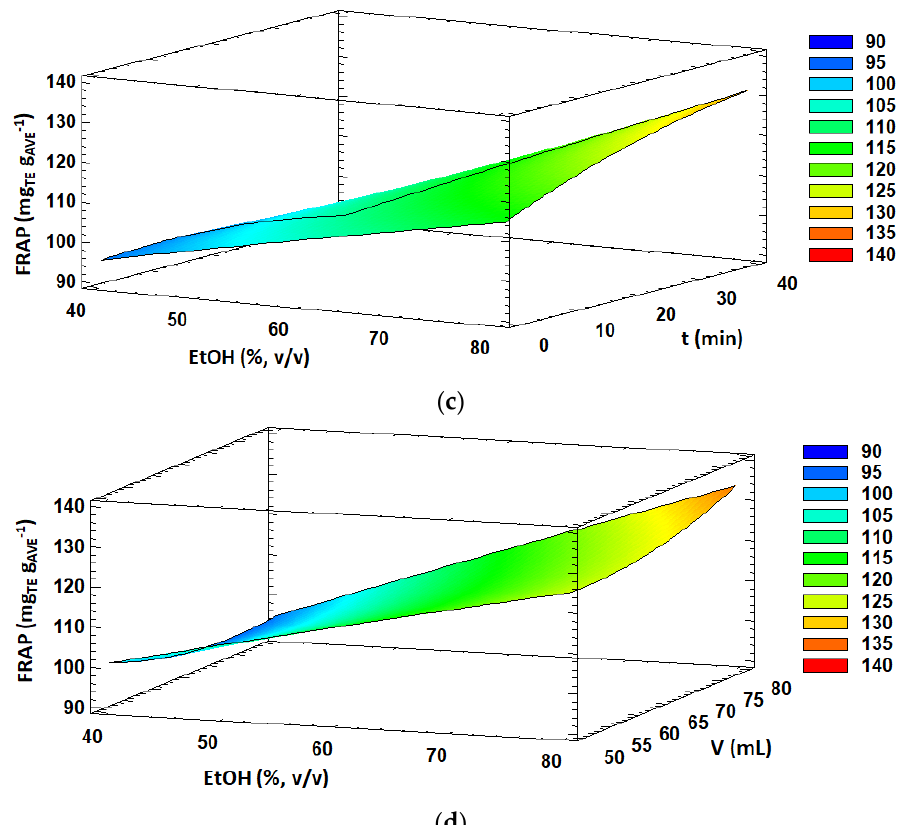
Figure 1. Response surface plots of significant interactions between independent variables on: ( a ) TPC (volume vs time); ( b ) DPPH (temperature vs time); ( c ) FRAP (ethanol concentration vs time) and ( d ) FRAP (ethanol concentration vs solvent volume). In all cases, the other factors were fixed at their central values.